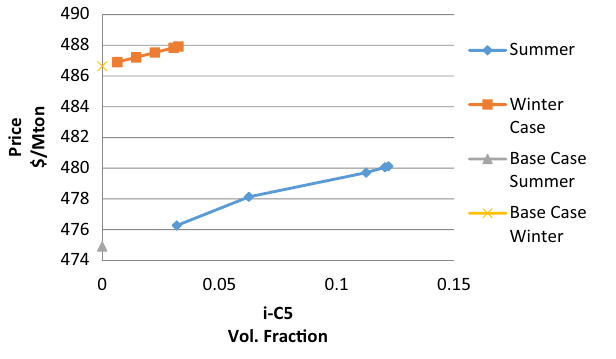
Fig. 13 Limitation of adding 2,2DMP to LPG